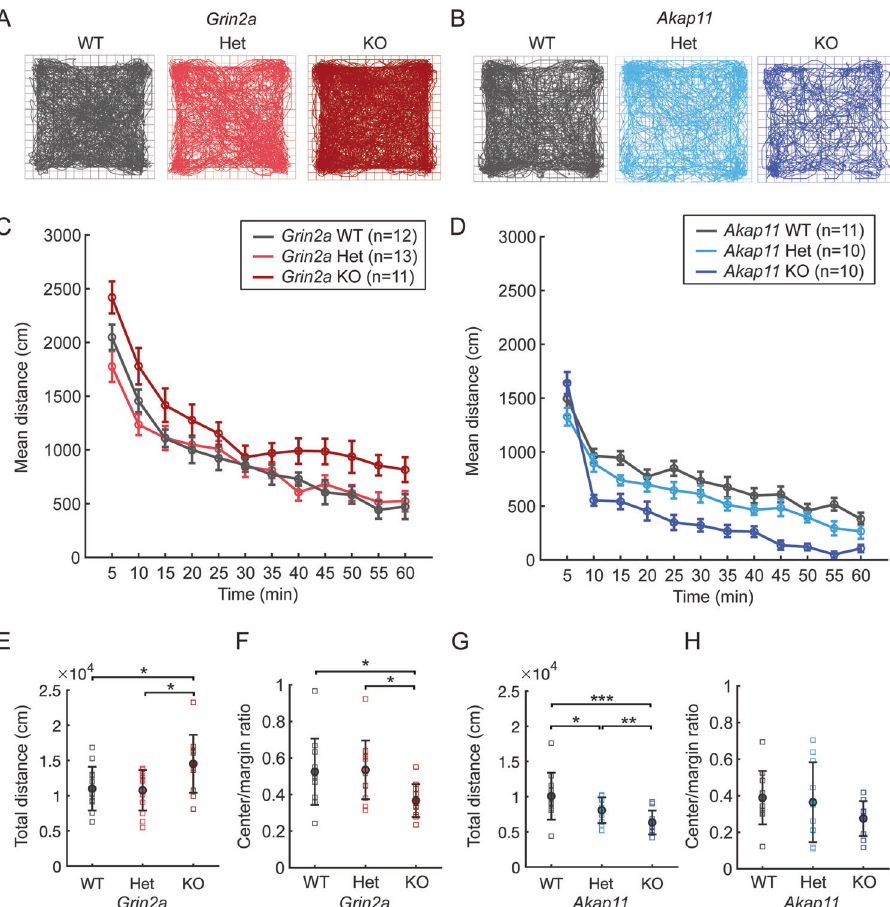
Fig. 1 Locomotor behavior of Grin2a and Akap11 mutant mice in open fi eld test. A , B Representative traces of mouse movements (60- minute test). C , D Mean distance traveled, binned into 5-minute segments. E – H Total distance traveled and ratio of center/margin distance in Grin2a (left) and Akap11 (right) mutants in comparison to WT littermates. Error bars denote mean ± standard error; * p < 0.05, ** p < 0.01, *** p <